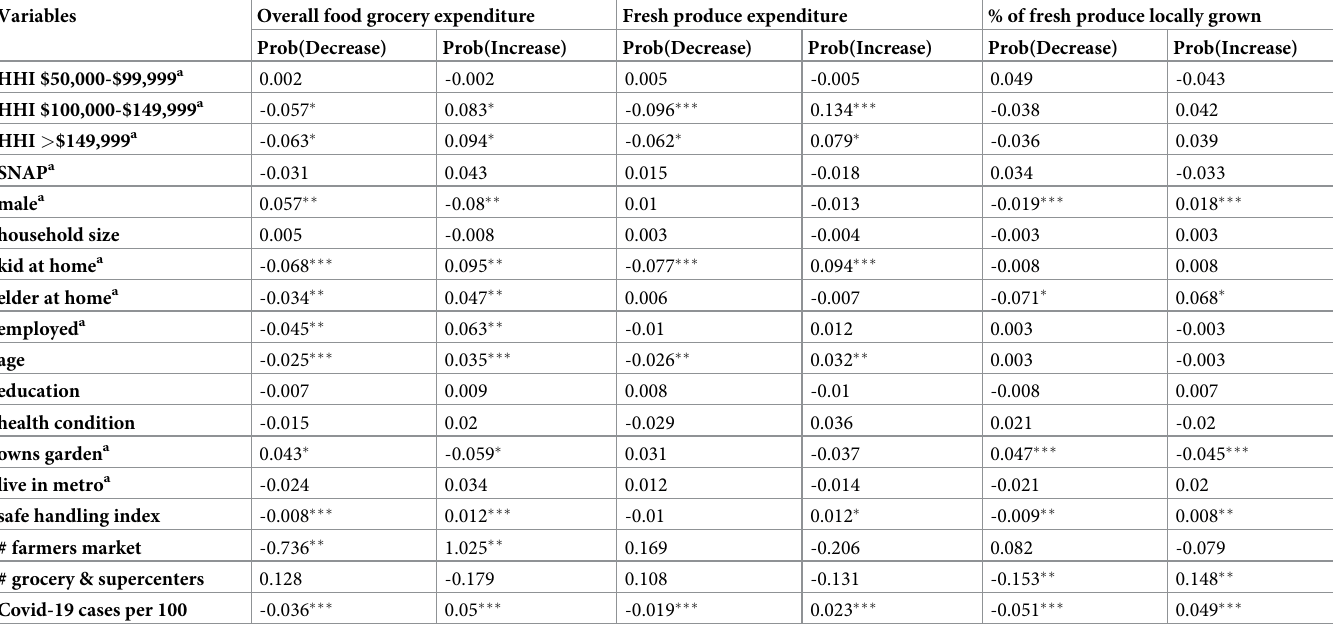
Table 3. Marginal effects of variables on overall food grocery spending, fresh produce expenditure, and share of locally grown fresh produce purchased.